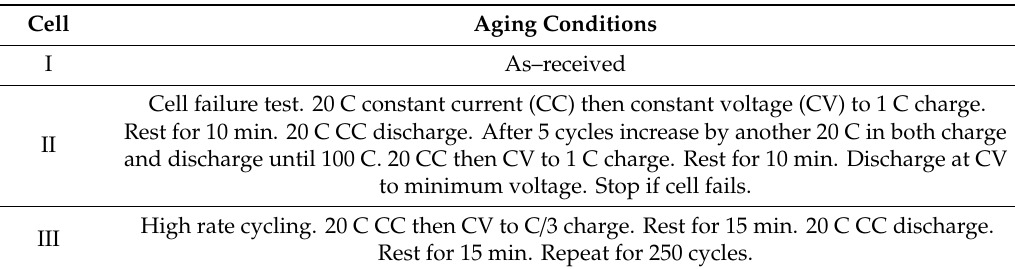
Table 3. Overview of cell aging situations.